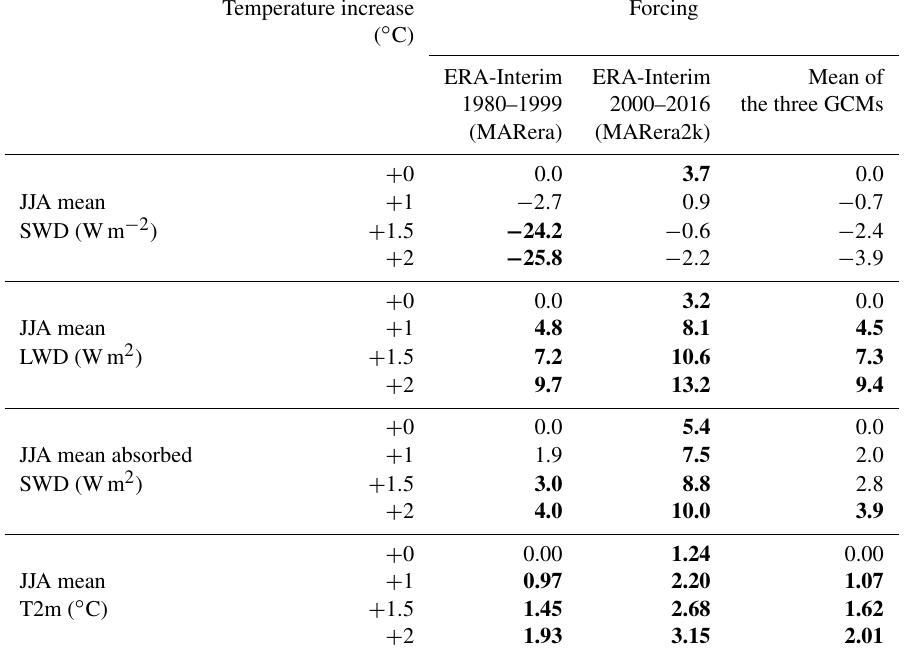
Table 3. Mean GrIS-integrated anomalies of summer energy fluxes (Wm − 2 ) and summer surface 2m temperature ( ◦ C) compared to 1980– 1999. Anomalies from GCM-forced simulations are given as averaged. Anomalies greater than the 1980–1999 standard deviation (i.e. greater than the inter-annual variability) of the simulation of MAR forced by unaltered ERA-Interim are shown in